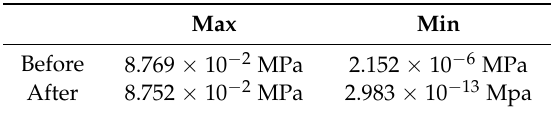
Table 2. Stress distribution before/after topology optimization.